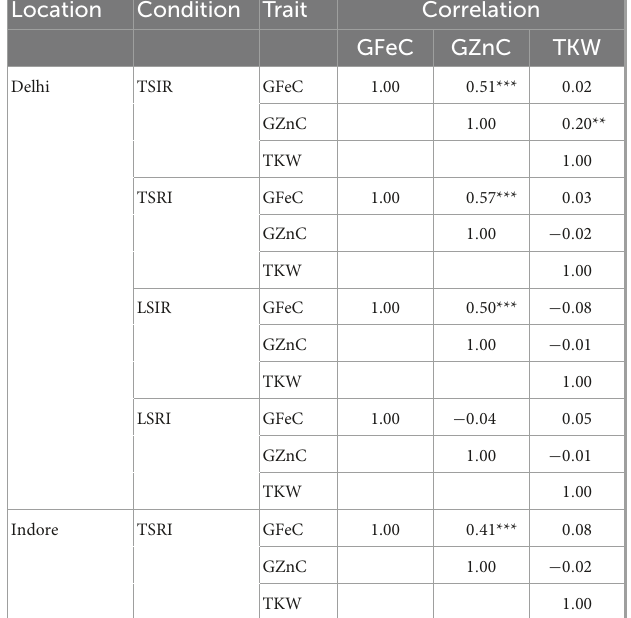
TABLE 4 Genotypic correlation coefficients among grain iron, zinc, and thousand kernel weight in the RIL population. Location Condition Trait Correlation